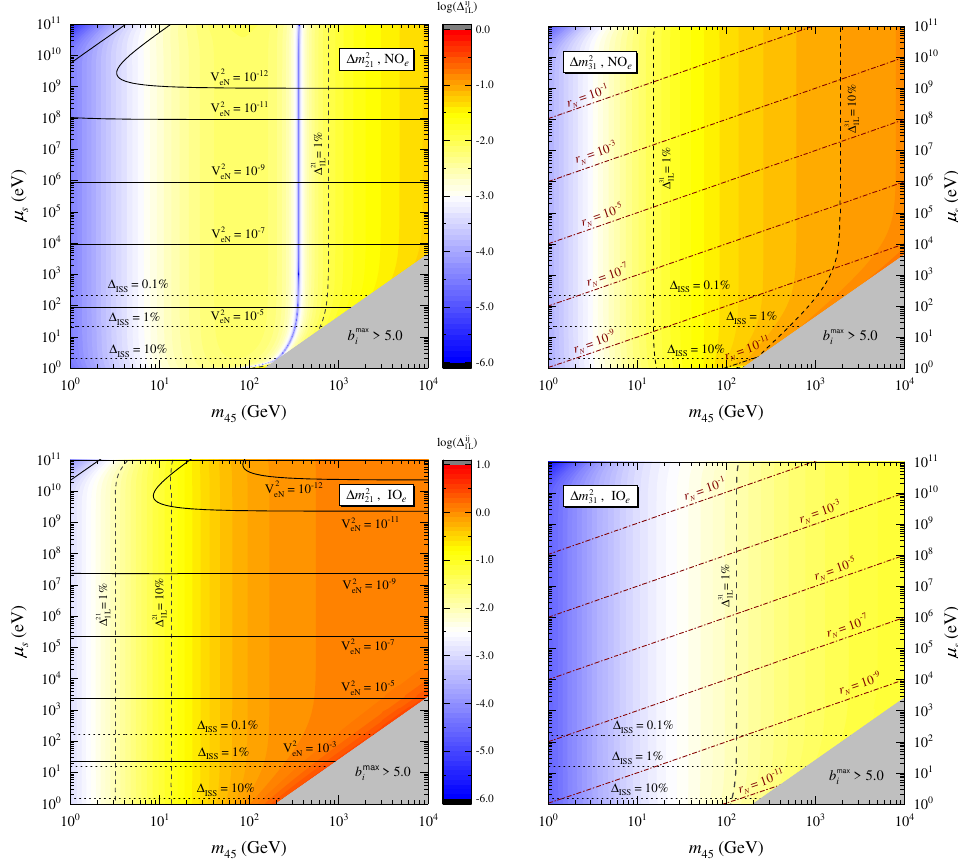
(left panels) and ∆ m 2 (right panels) for the 21 31 (lower panels) cases. The coloured contour levels are for the ∆ ij e 1L = 1% , 10% . 1L , r and ∆ contours, respectively. eN N ISS > 5 i